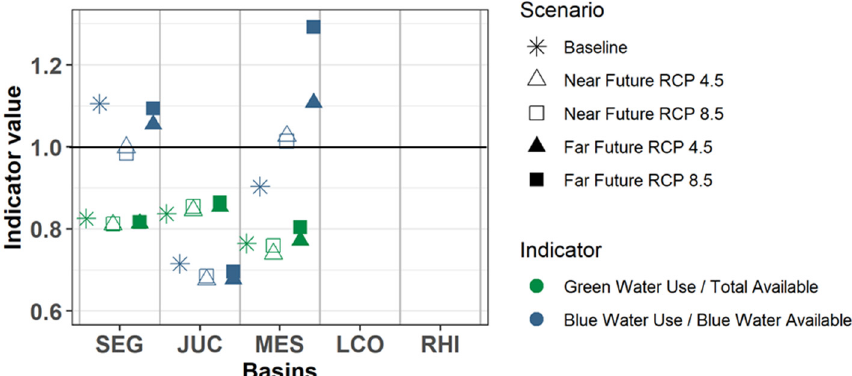
Figure 5. Water stress indicators: (1) Green water use versus total available and (2) blue water use versus blue water available for the five river basins under the baseline and climate change scenarios.